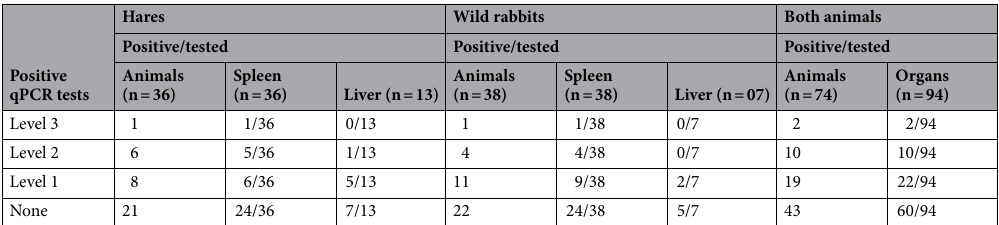
Table 2. qPCR test results for hares and wild rabbits and their organ samples. Level 3: ISftu2, Tul4, and Type B qPCR positive; Level 2: ISftu2 and Tul4, but not Type B qPCR positive; Level 1: only ISftu2 qPCR positive; none: no qPCR